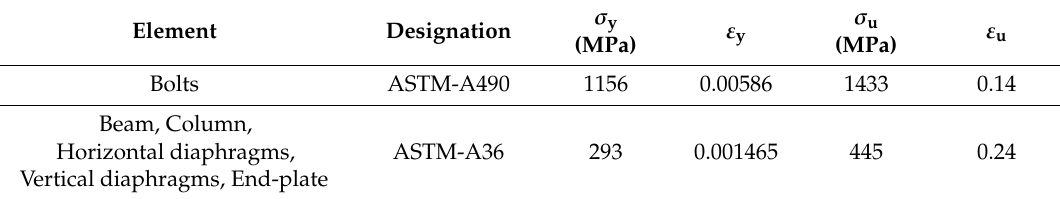
Table 3. Material constitutive law parameters of steel elements, according to [18].